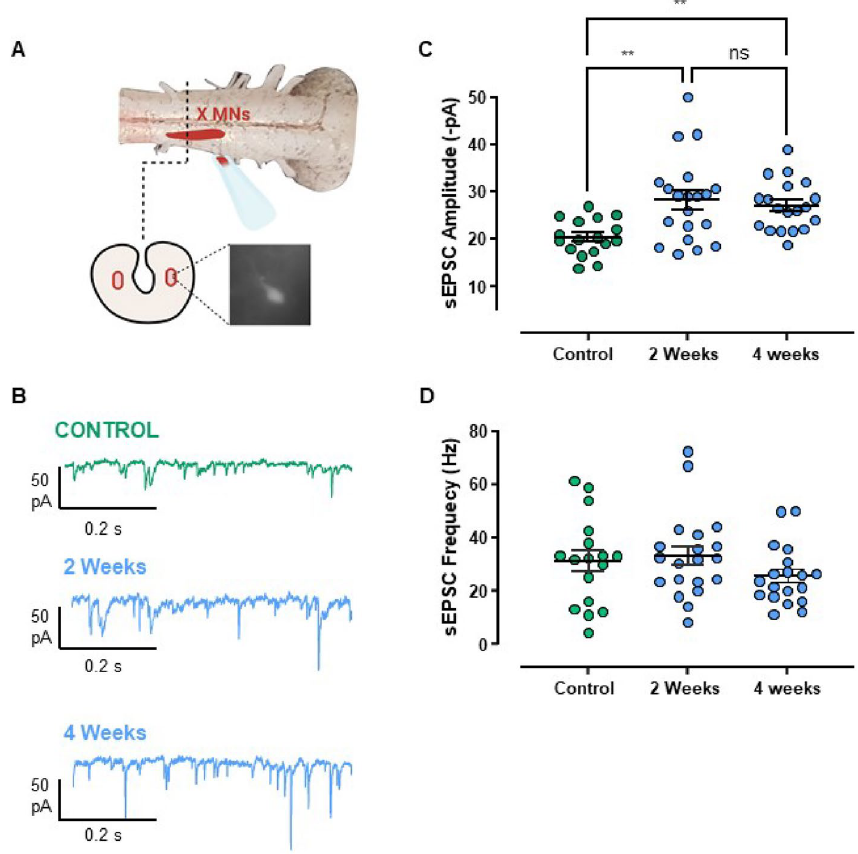
Figure 1. sEPSC amplitude, but not frequency, increases by 2 weeks of cold-acclimation. ( A ) Schematic of the experimental process to label respiratory motoneurons. The 4th root of the vagus nerve complex was backfilled with fluorescent dextran, and neurons were identified in slices through fluorescence imaging microscopy. Animals were either warm-acclimated (control; 22 °C; n = 17 from 6 animals), or cold-acclimated for two (n = 20 from 4 animals) or four weeks (n = 19 from 4 animals). ( B ) Example voltage clamp recordings of sEPSCs in laryngeal motoneurons from controls and frogs that hibernated for 2 and 4 weeks. ( C ) sEPSC amplitude was increased at 2 weeks and remained elevated at 4 weeks (One-way ANOVA; p = 0.0013), but sEPSC frequency was not affected ( D , p = 0.287, Kruskal–Wallis test). Dots represent data points for individual neurons, and average values are indicated by the horizontal line. Error bars are S.E.M. **p < 0.01. Error bars are